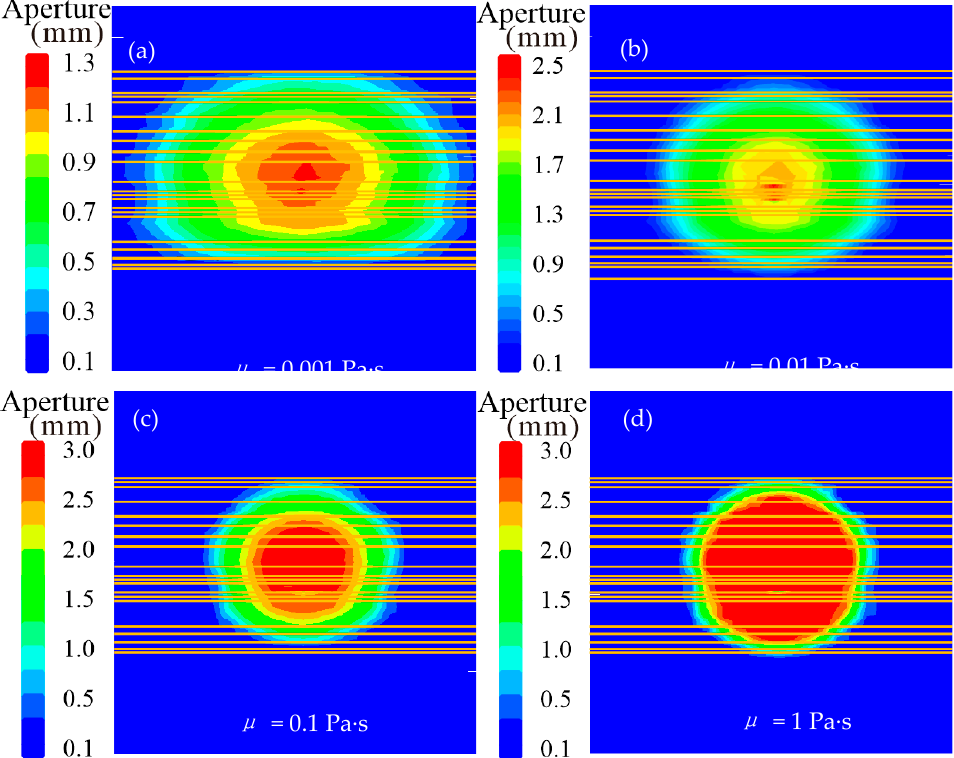
Figure 9. Fracture geometry and aperture distribution in different cases, with the fluid viscosity of